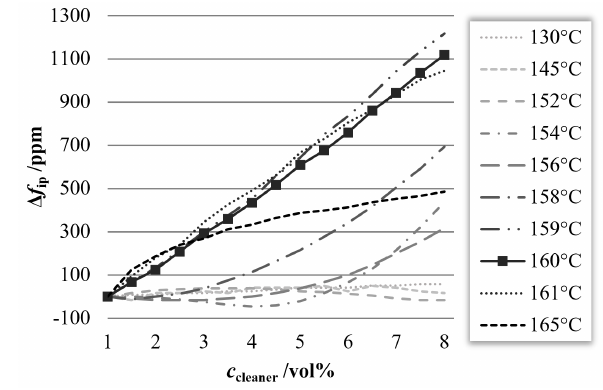
Figure 12. Normalized sensor sensitivity for different cross-linking temperatures at a given time t oven = 25min (see Table A4 for the corresponding t cl